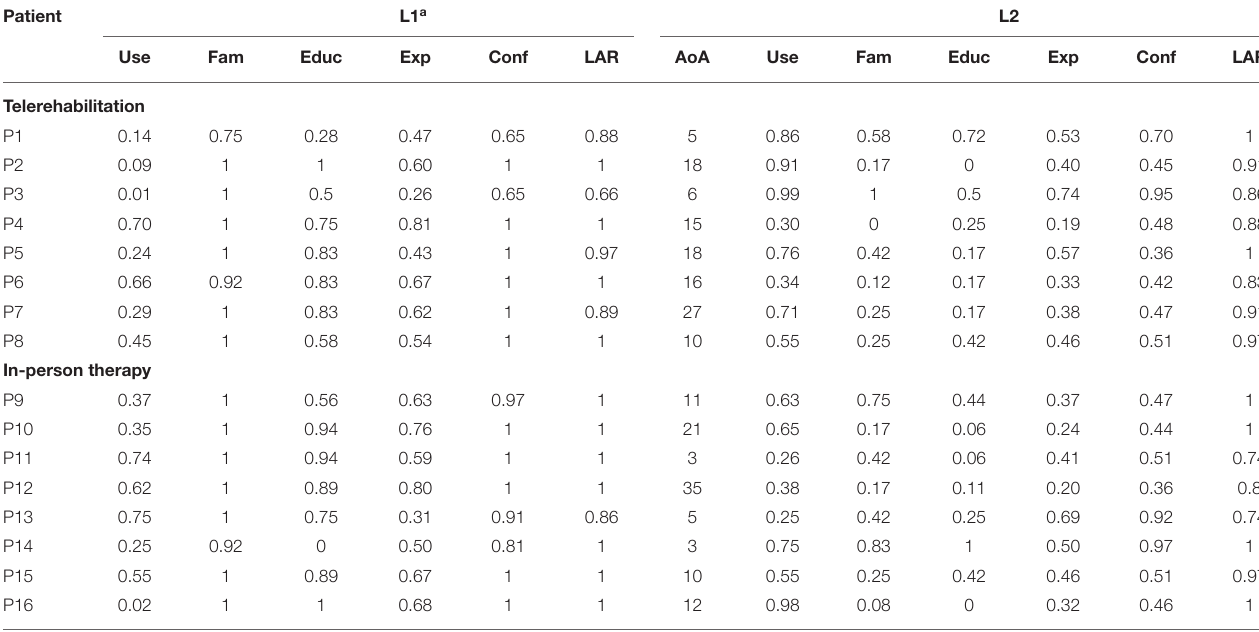
TABLE 2 | Prestroke bilingual background of the bilingual adults with aphasia as measured by the Language Use Questionnaire.